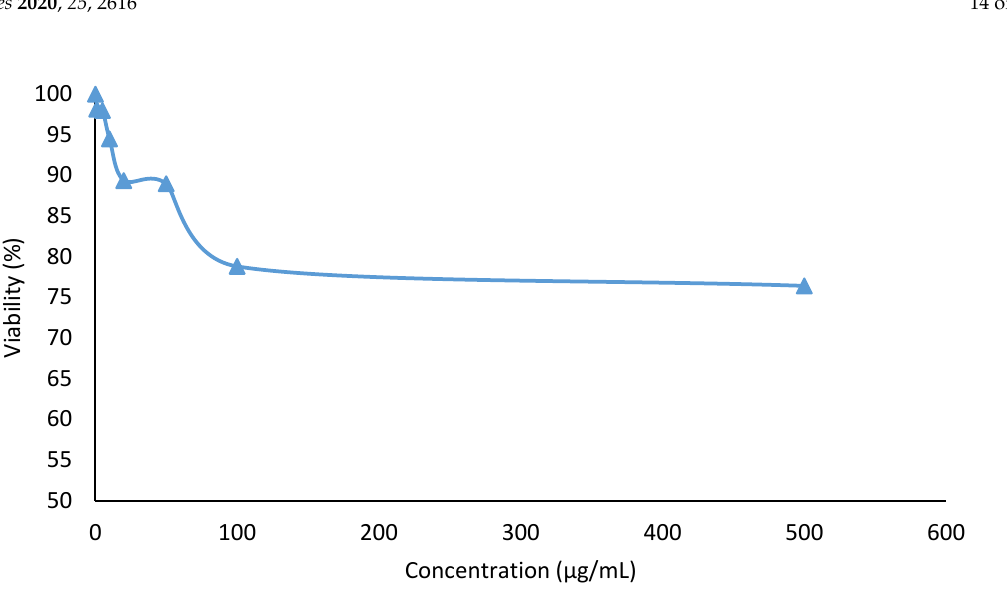
Figure 8. Fifty percent inhibition of cell viability (IC 50 ) of optimized nanoemulsion containing KMO against 3T3 cell line.